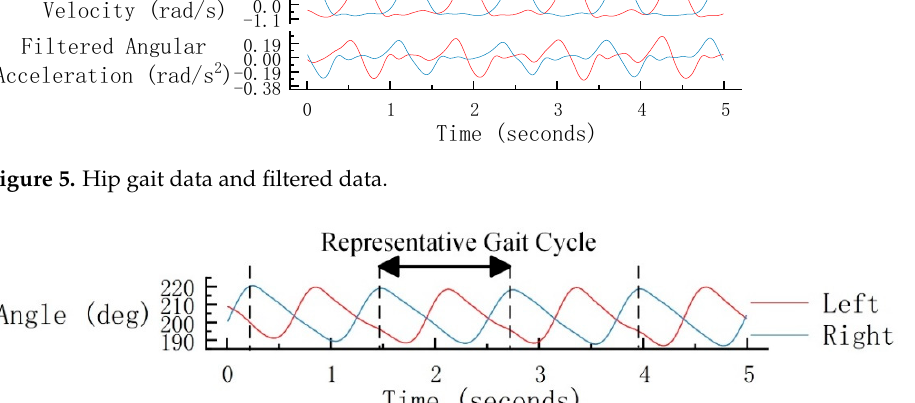
Figure 6. Gait data segmentation base on DTW.